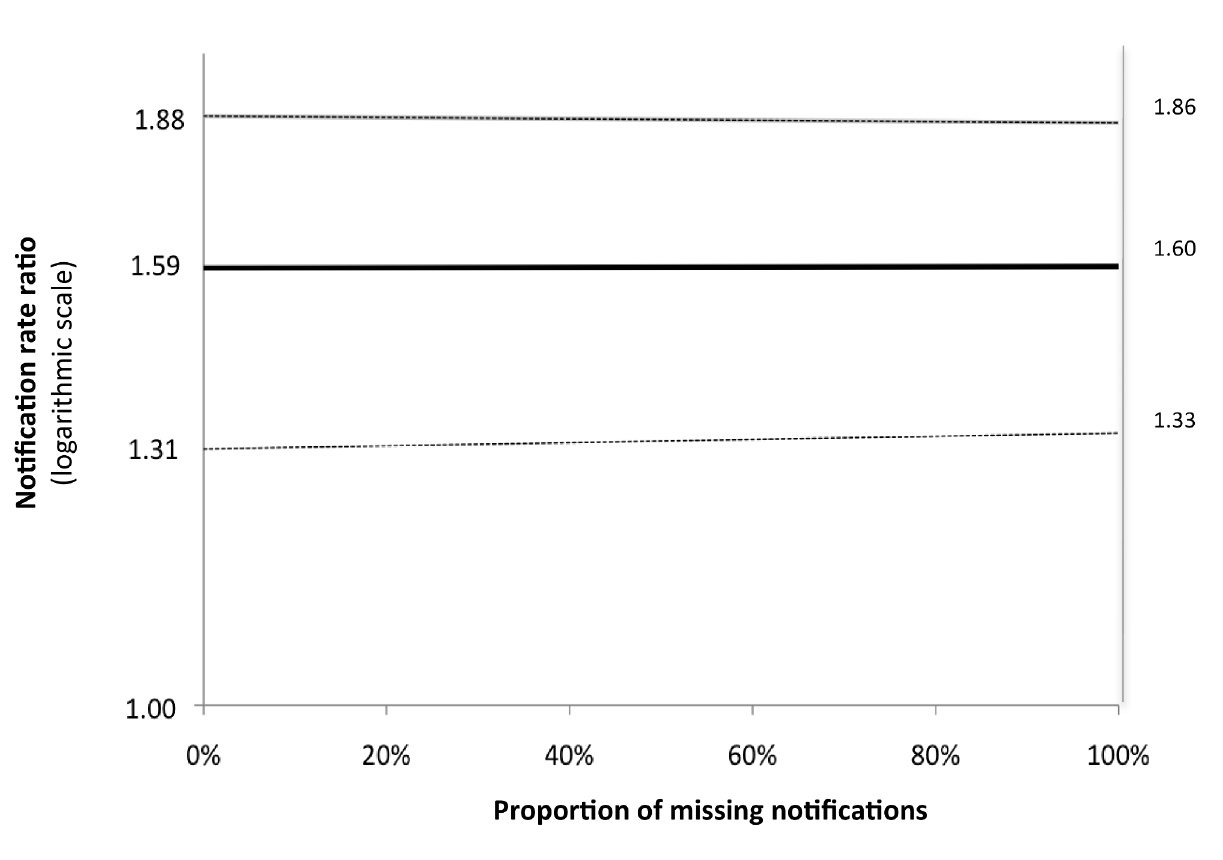
Figure 3. Sensitivity analysis for laboratory-confirmed TB diagnoses. Variation in unadjusted cluster-averaged notification rate ratio for laboratory-confirmed notifications, by proportion of missing notifications for laboratory-confirmed TB diagnoses that are due to failed linkage of records in the laboratory and notification databases.